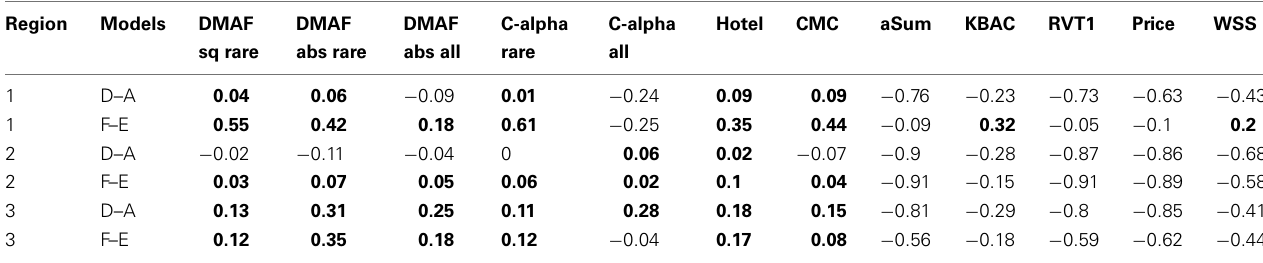
Table 5 | Difference in power of each method between models D andA and models F and E.